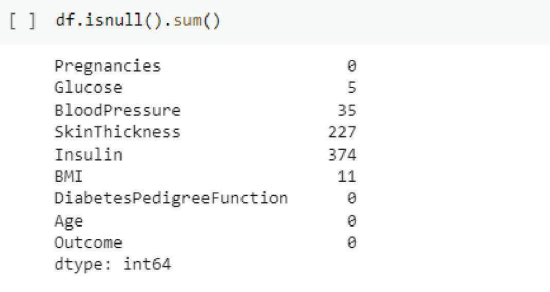
Figure 5: Before data preprocessing.